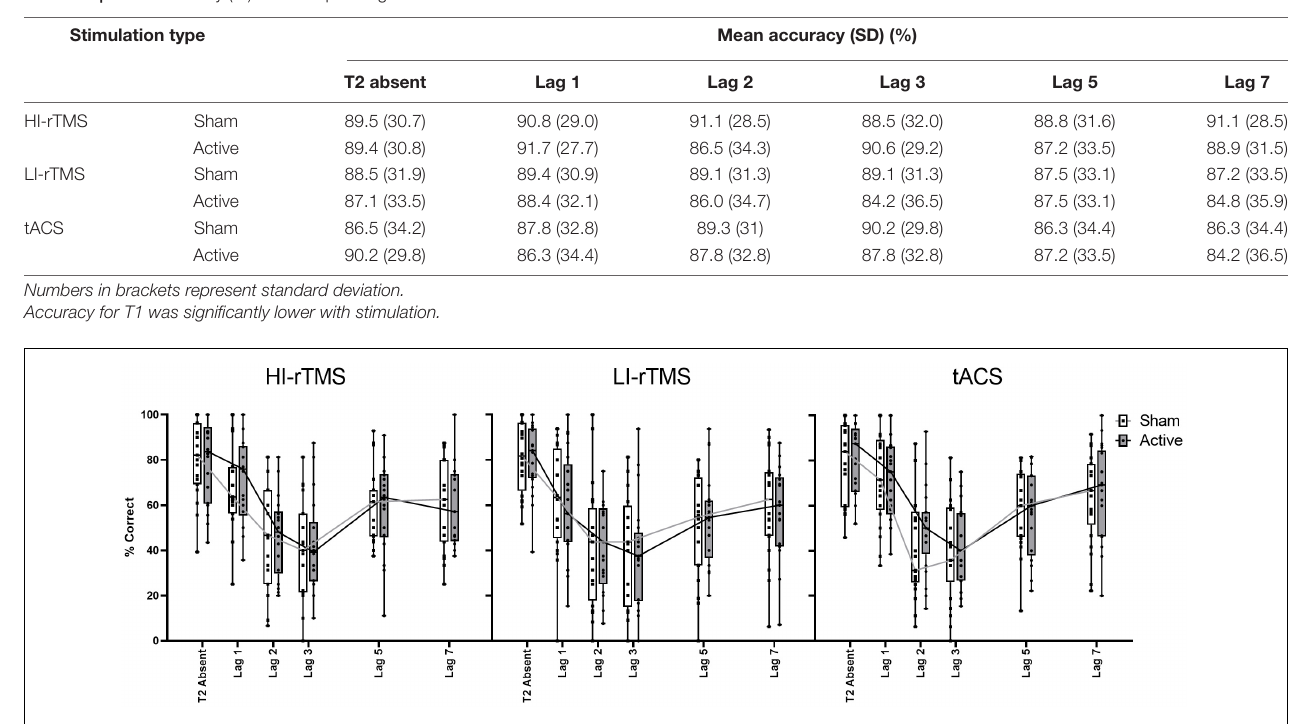
FIGURE 4 | Percentage accuracy for reporting T2| T1 across lag positions for each stimulation type. The attentional blink occurred with Lag 1 sparing. Accuracy did not differ between stimulation parameters for T2| T1. Individual points represent mean accuracy for individual